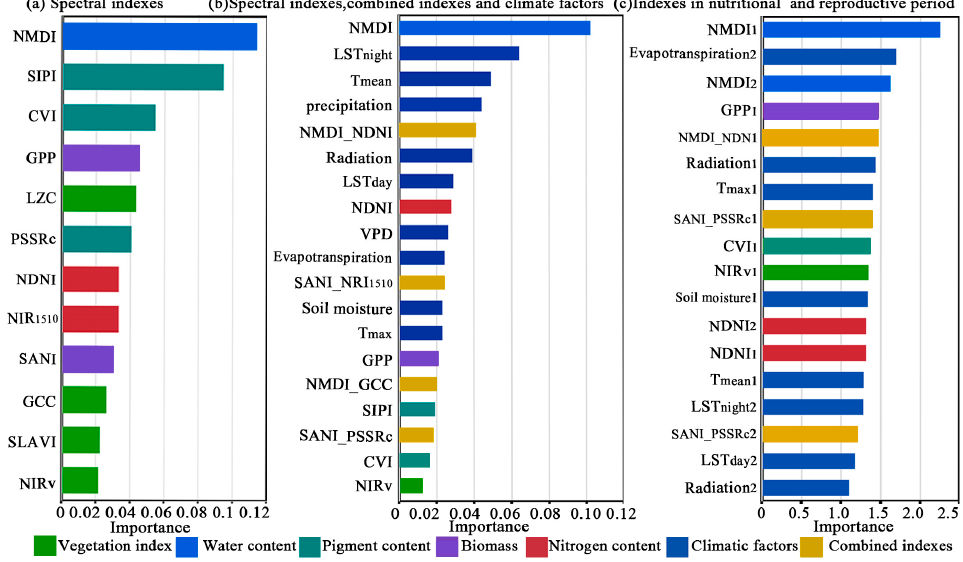
Figure 4. Importance ranking of the ( a ) spectral indexes, ( b ) three types of indexes (spectral indexes, combined indexes and climate factors) and ( c ) indexes for the vegetative and reproductive growth periods. Note: NMDI represents the value of the whole-growth period; NMDI 1 represents the value of the vegetative growth period; and NMDI 2 represents the value of the reproductive growth period.